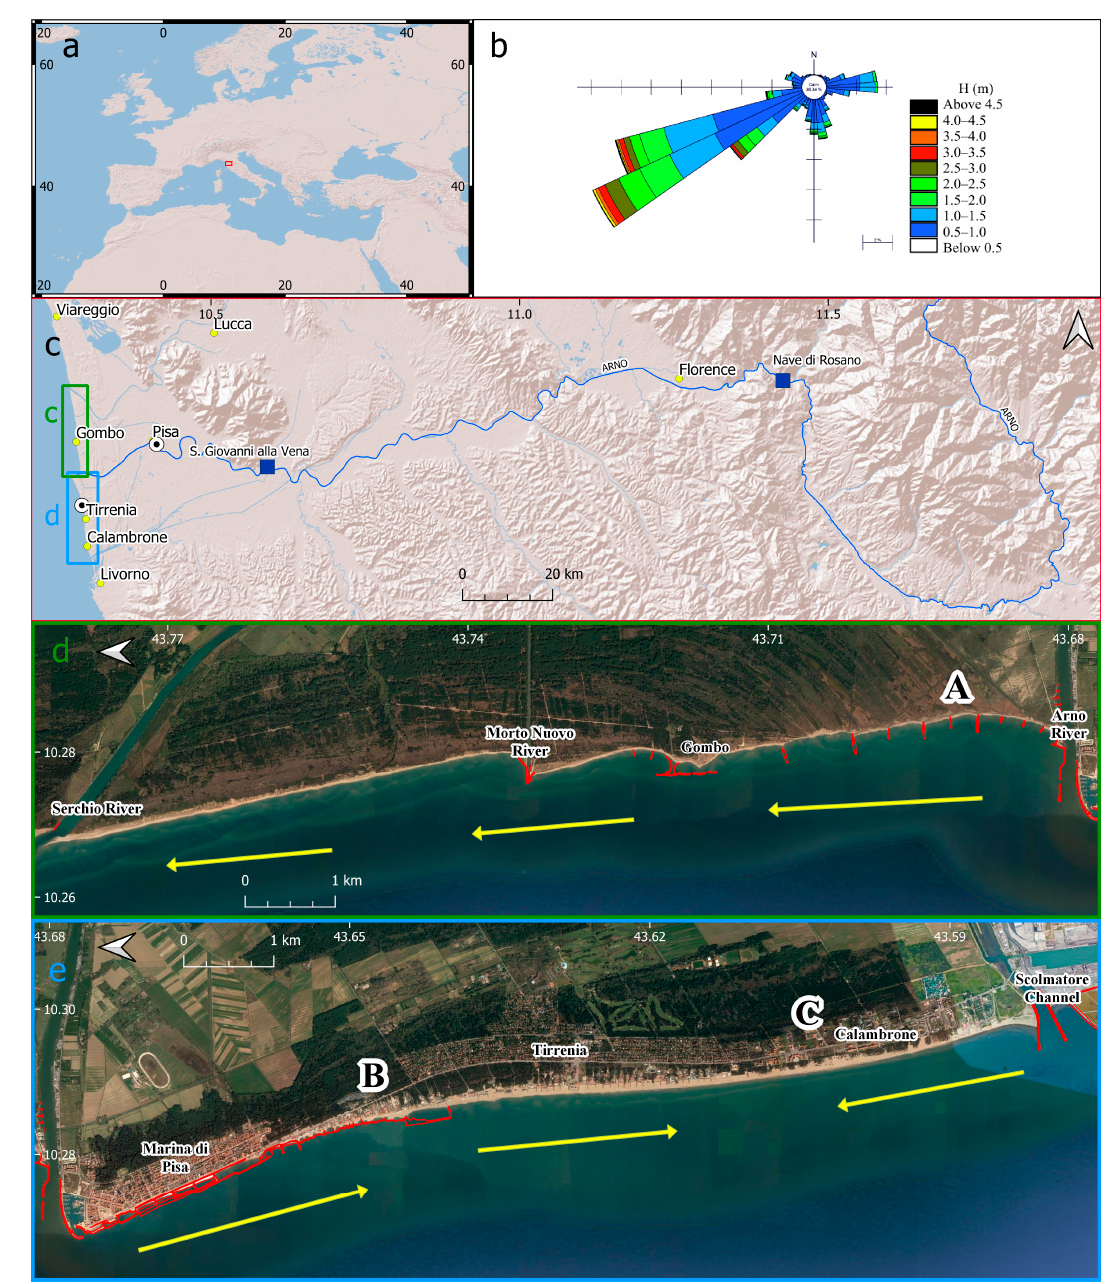
Figure 1. A, B and C indicate specific coastal stretches to which reference has been made in the text. Location map of the study area ( a , c – e ); ( b ) directional analysis of wave data (https://www.cfr.toscana.it/index.php?IDS=42&IDSS=282) recorded at the Gorgona Buoy (43.57N; 9.95E) grouped by average direction of origin and by height wave classes, data between 1 October 2008 and 1 May 2012 (modified after [34]); ( c ) Arno River course (blue line), discharge gauges (blue squares), location of samples used for grain-size analyses (black and white dots); ( d , e ) northern and southern sectors respectively of the study area. Yellow arrows indicate the littoral drift direction [11,22]), the red line indicates the coastal defense